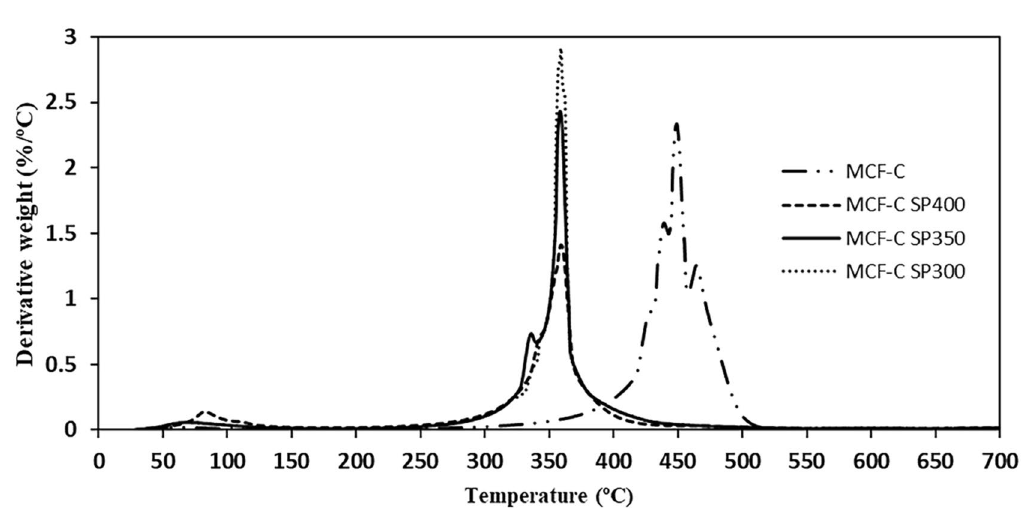
Figure 9. Differential thermal analysis of the fresh and spent